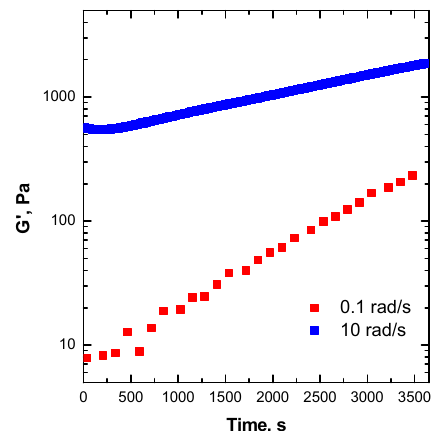
Figure 1. Time sweep measurements at two angular frequencies carried out at 180 ◦ C for epoxidized natural rubber (ENR) 25. Preliminary tests.